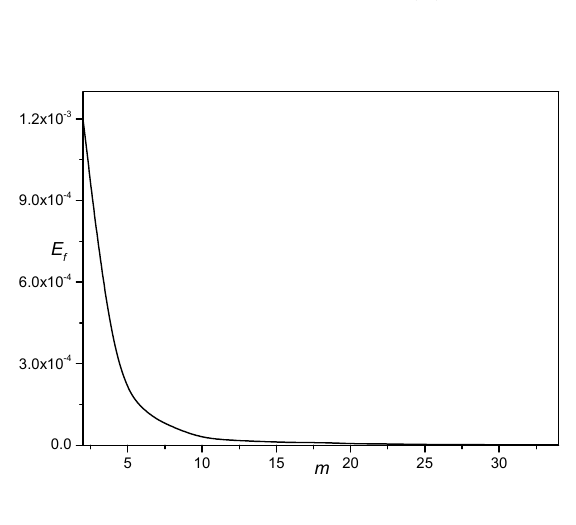
Fig. 4 The h curve of φ ( λ )